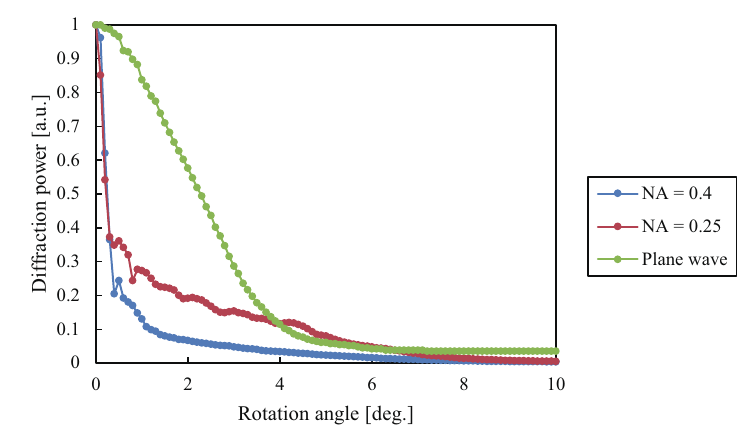
Figure 6. Rotational selectivity.